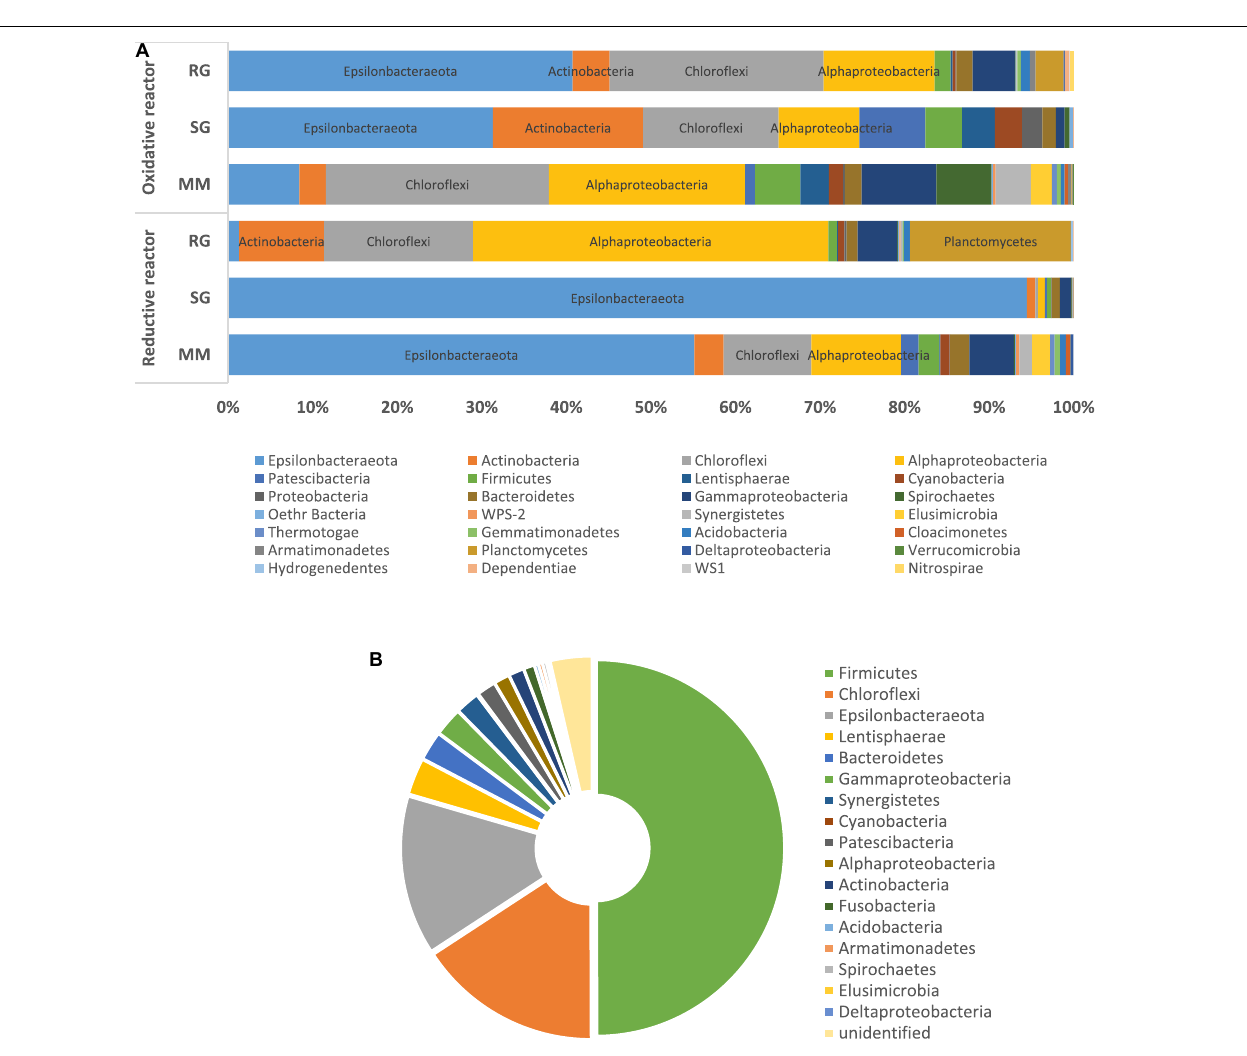
FIGURE 1 | Microbiome composition at high phylogenetic levels (i.e., phylum or class) of the reductive and oxidative reactors under different feeding conditions. (A) Mineral medium (MM), synthetic groundwater (SG), and real groundwater (RG). (B) Microbiome composition at the phylum level of the RG collected from the contaminated site and used as feed for the